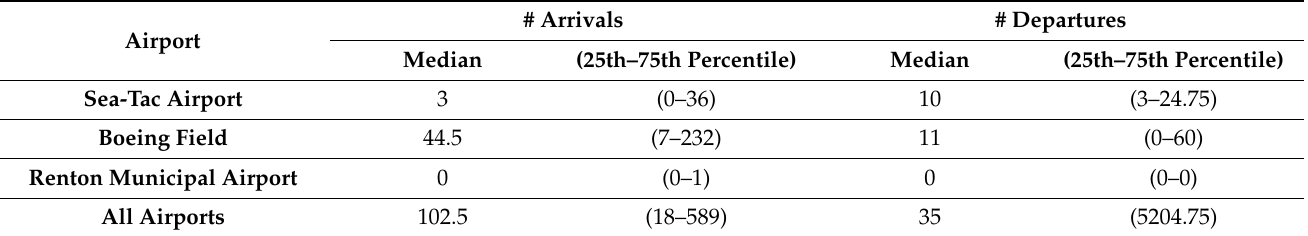
Table 7. Number of arrivals and departures below 750 m and within a one-mile radius of King County Schools in 2019. Flight information including the median and 25th–75th percentiles are provided for the three airports in the region.